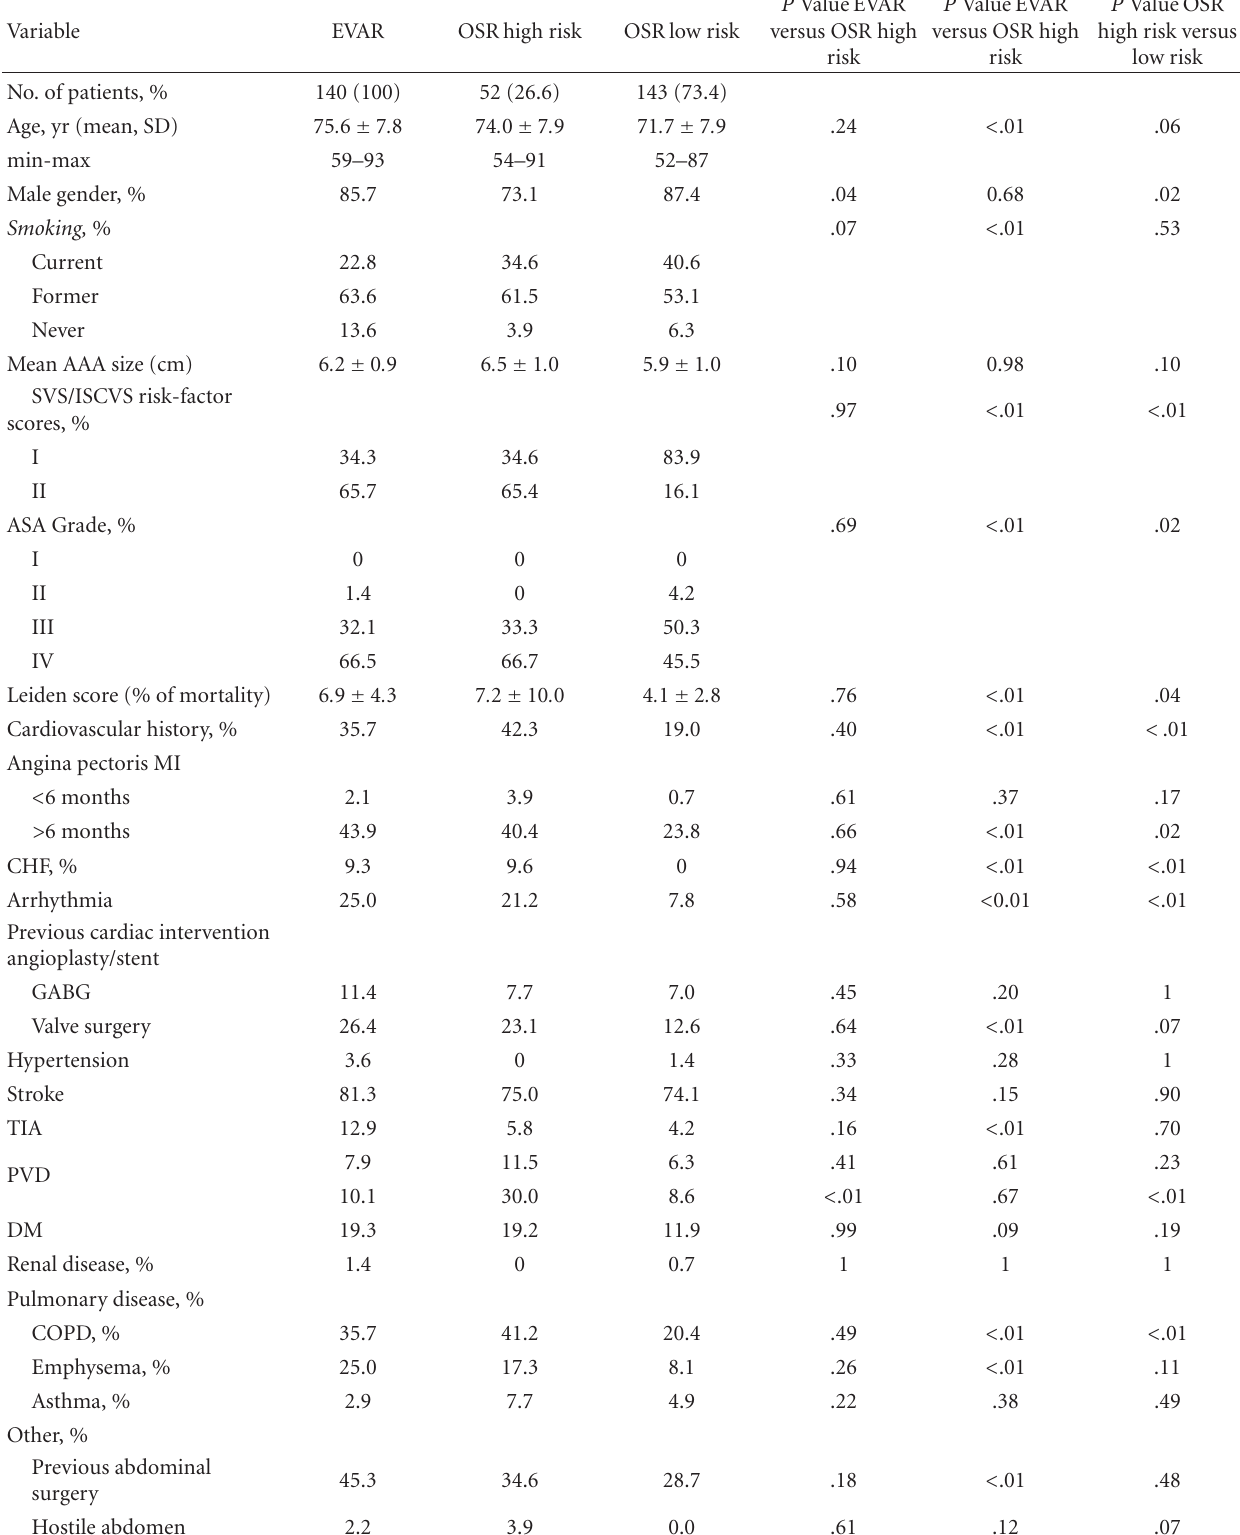
Table 1: Baseline characteristics of study